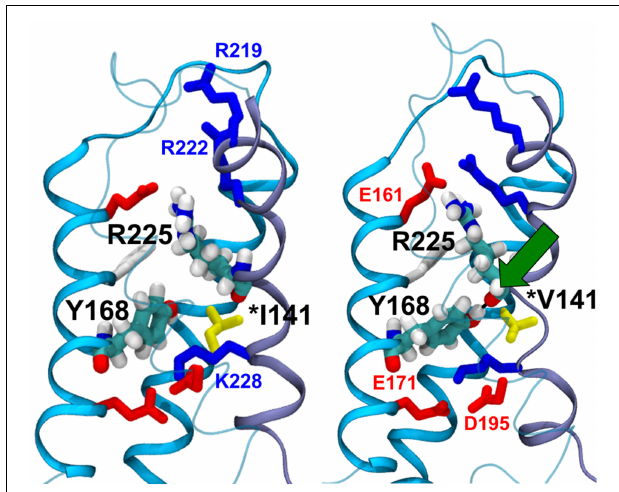
FIGURE 3 | Molecular dynamics simulation of the WT (left panel) and the p.I141V mutants (right panel) of Na v 1.4 channel. In the presence of the p.I141V mutation, the model predicted the formation of a hydrogen bond (Green arrow) between the S2-Y168 and S4-R225 residues, thus stabilizing the open confirmation of the channel; (From Amarouch et al.,